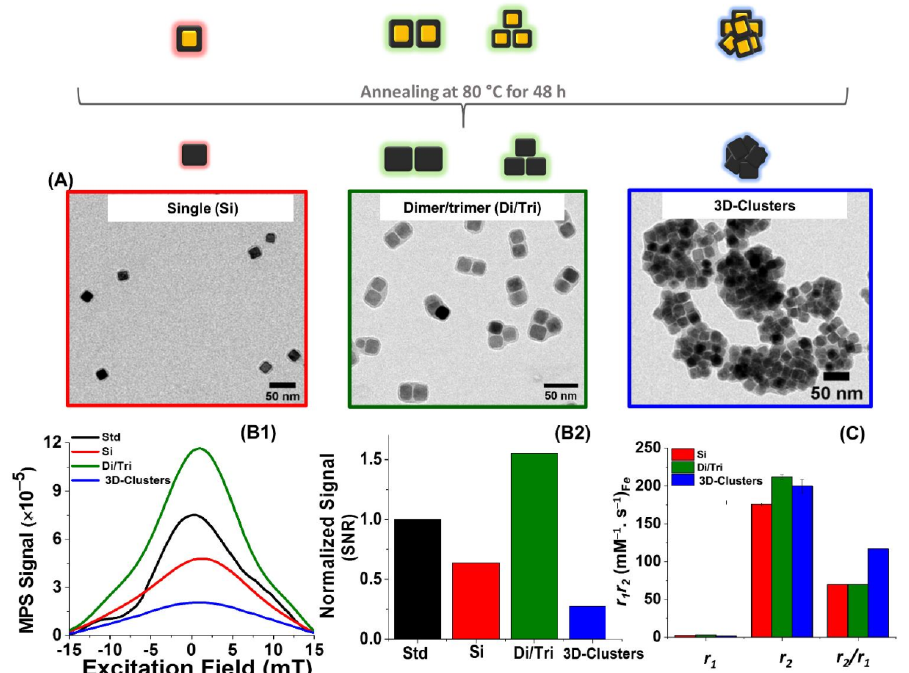
Figure 1. Scheme of the thermal annealing step performed on clusters to promote the transformation of core-shell nanocubes in the clusters to single Fe 3 O 4 phase. ( A ) Representative TEM images of MNP assemblies made from core-shell IONCs and encapsulated within a PScMA polymer matrix having a single (Si) nanocube, a short-chain dimer/trimer (Di/Tri), and a 3D-Clusters configuration, respectively. Please note that the cluster samples were thermally annealed prior to TEM image collection to convert the core-shell IONCs into single-phase Fe 3 O 4 . ( B1 , B2 ) MPI analysis of the nanocube assemblies: ( B1 ) shows the point spread function (PSF) obtained for each sample in comparison to the MPI signal of a commercial reference standard VivoTrax™ (Std) measured at 16 kHz and 20 mT, and ( B2 ) displays the histograms of the corresponding signal to noise ratios (SNRs), which have been normalized to the signal of the reference standard. ( C ) Magnetic resonance relaxation rates of all the three structures measured in water upon exposure to a static magnetic field of 1.5